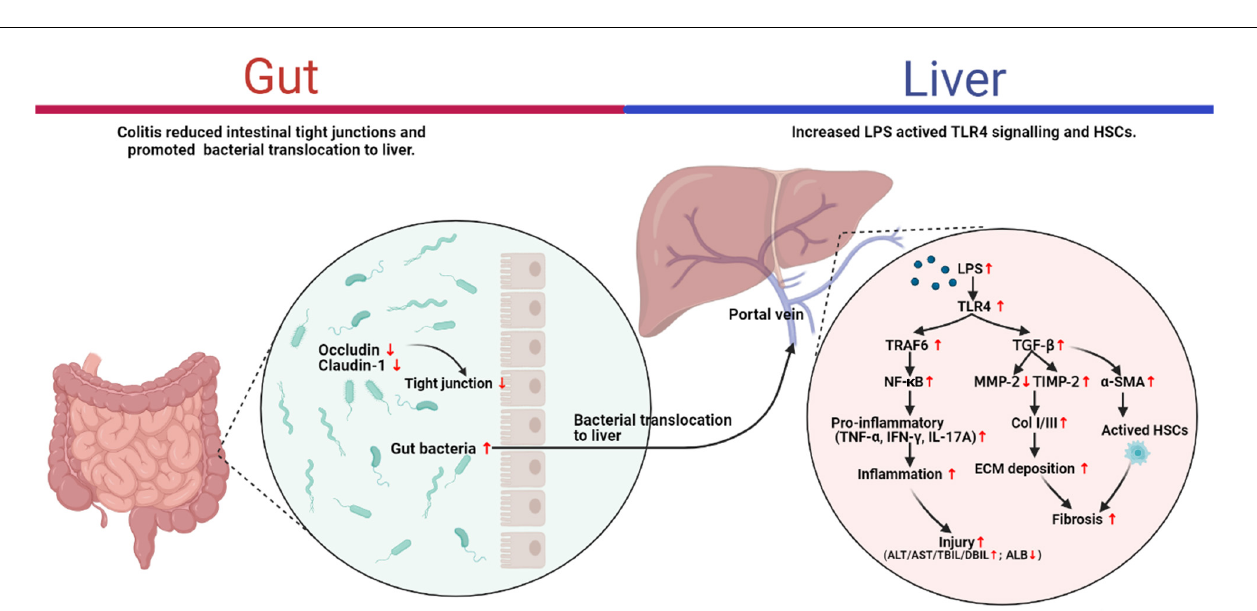
FIGURE 5 | DSS promoted the activation of TLR4 signaling in CCl 4 -induced liver fibrosis mice. (A) Representative images of IHC staining liver sections (magnifications × 400) and (B) staining intensity of proteins in TLR4 signaling were shown; (C–E) Expression levels of proteins in TLR4 signaling in liver were measured by qRT-PCR (C) and western blot (D,E) . Data were expressed as mean ± SD. ∗ , p < 0.05.